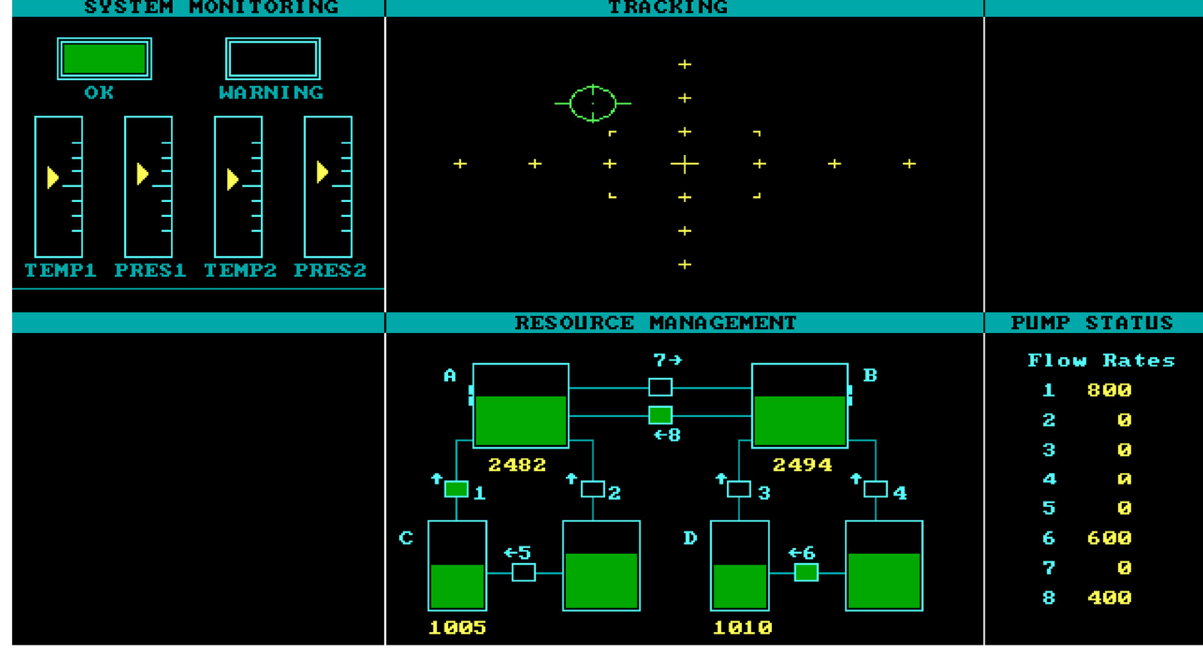
FIGURE 1 | The Multi-Attribute Task.